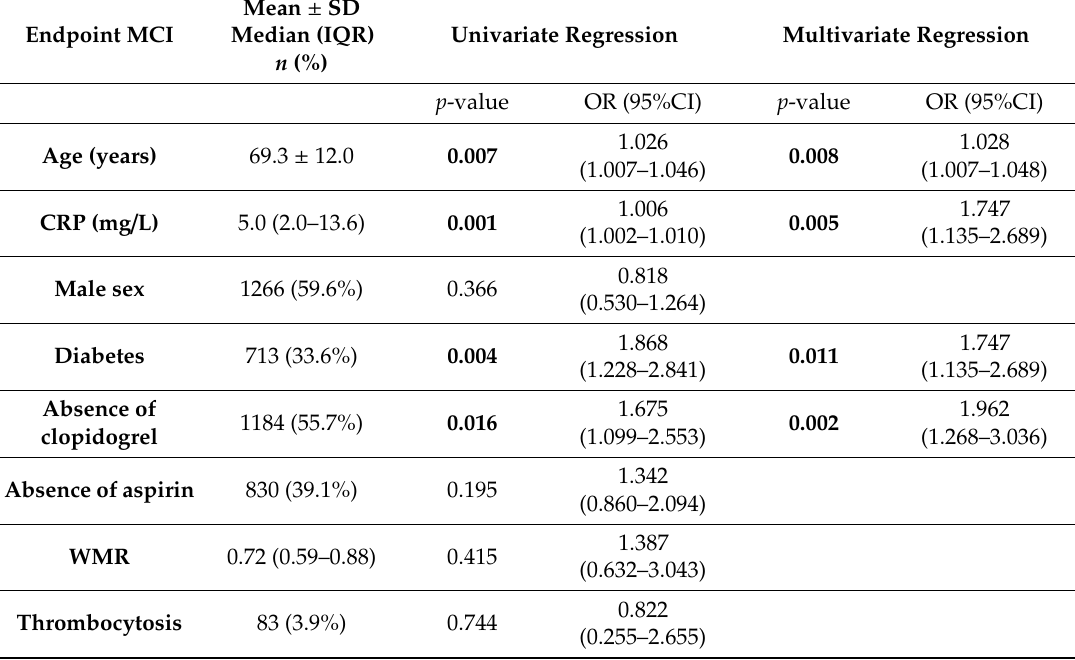
Table 3. Univariate and multivariate regression analysis for the endpoint of myocardial infarction